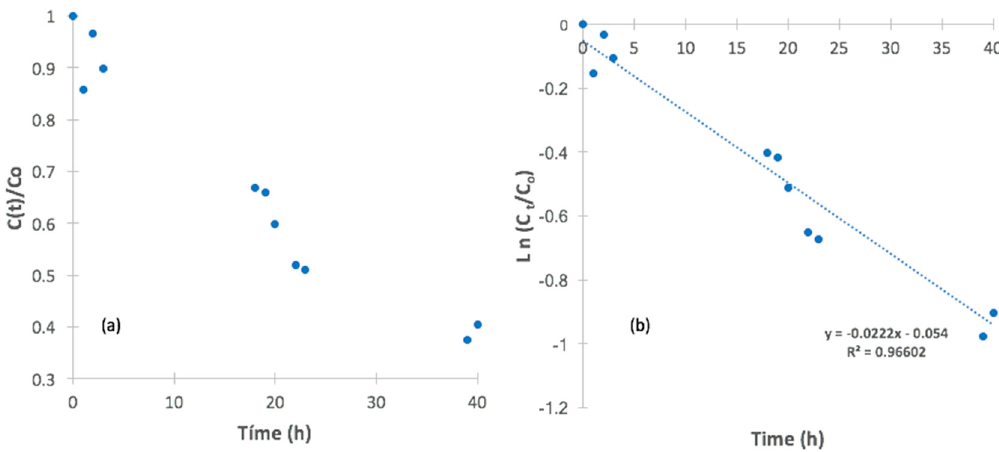
Figure 3. ( a ) Kinetics of bioremediation of methylene blue (MB) at an initial concentration of 50 ppm per action of the yeast G. geotrichum KL20A at 35 °C. ( b ) Model L-H on kinetic data of MB removal for the yeast at an initial concentration of 50 ppm, temperature at 35 °C and pH 7.0.